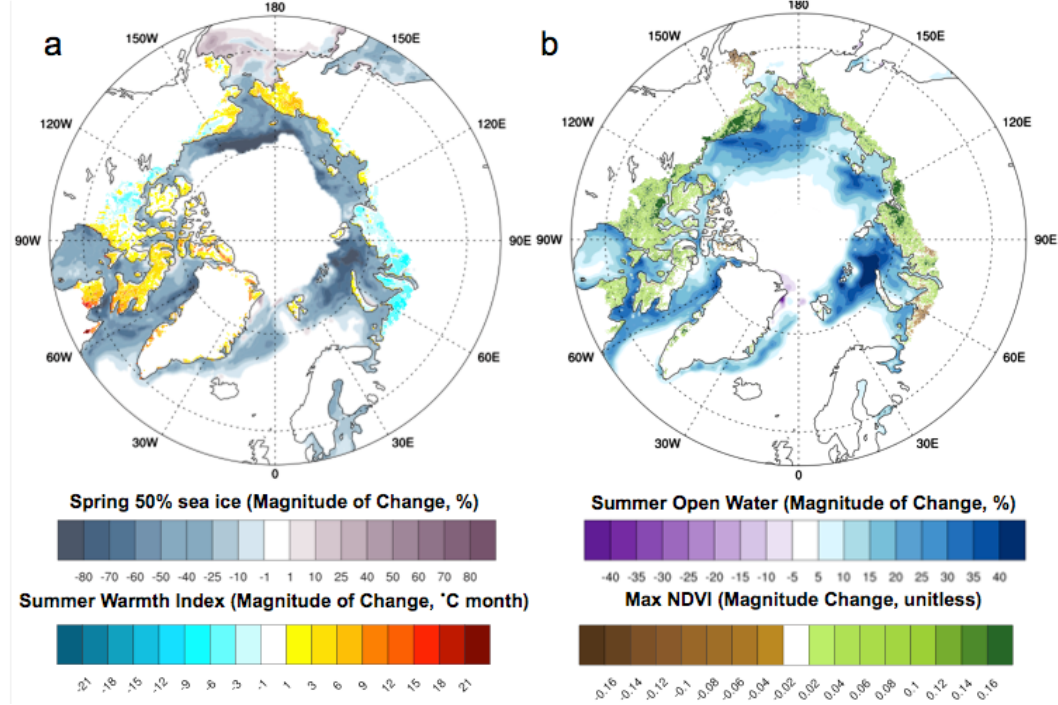
Figure 2. Magnitude trends (1982–2011) for ( a ) spring sea-ice concentration (%) (as represented by trends from the climatological 50% sea-ice concentration level) and land-surface summer warmth index (SWI) (°C month), ( b ) summer (May–August) open water area (%) and annual MaxNDVI (unitless). Trends were calculated using a least squares fit (regression) at each pixel. The SWI is the annual sum of the monthly mean temperatures > 0 °C, derived from AVHRR thermal channels 3 (3.5–3.9 μ m), 4 (10.3–11.3 μ m) and 5 (11.5–12.5 μ m). The total trend magnitude (regression times 30 years) over the 1982–2011 period is